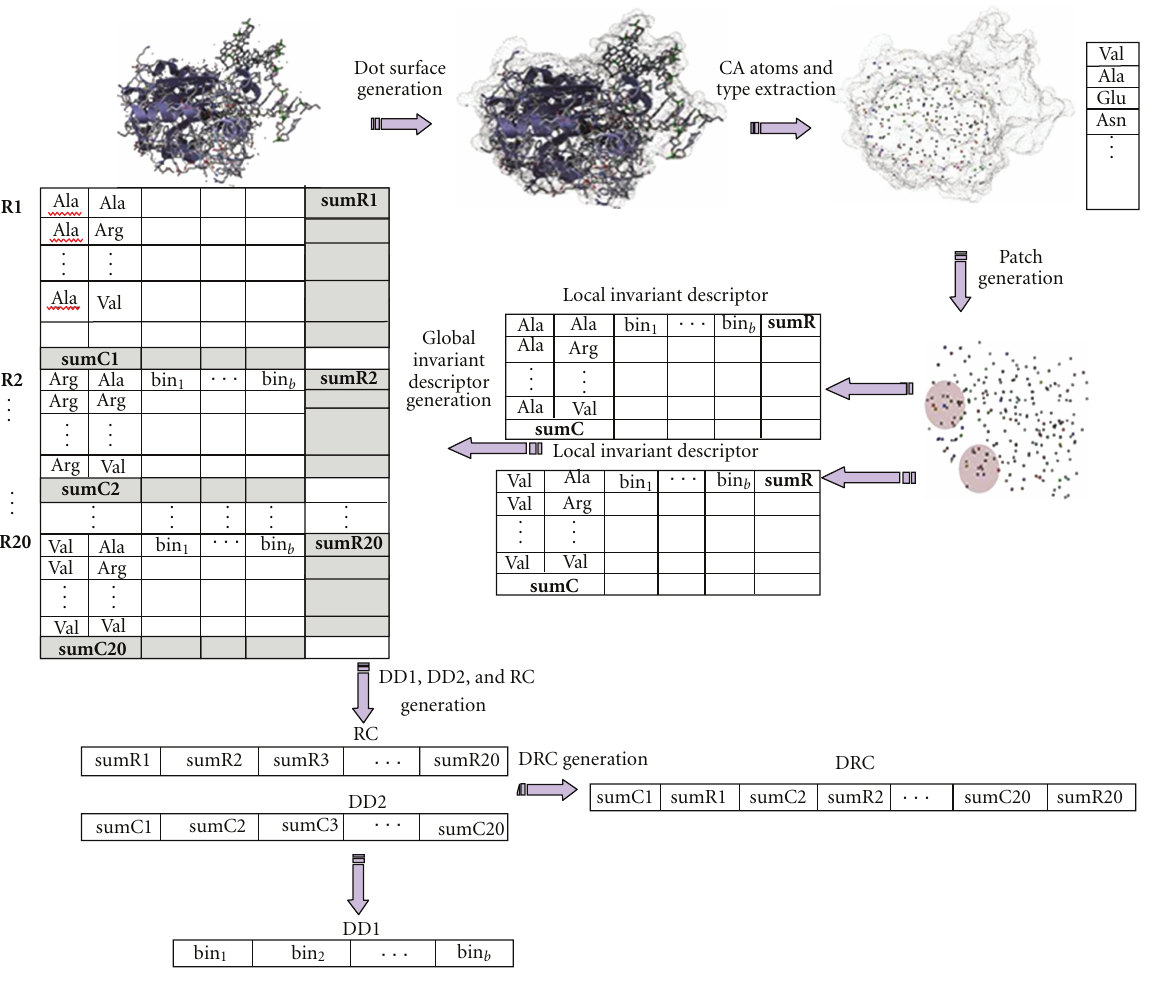
Figure 2: Schematic diagram for the protein surface characterization using an invariant descriptor. Protein structures in the figure are produced using PMV